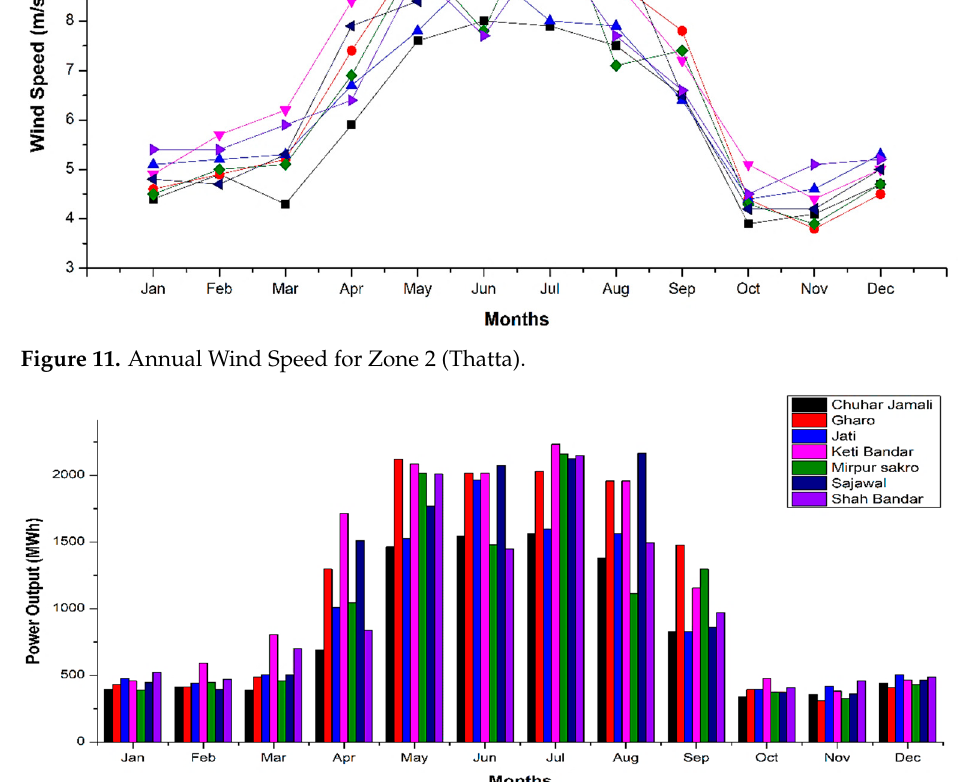
Figure 12 . Power output in MWh for Zone 2 (Thatta).